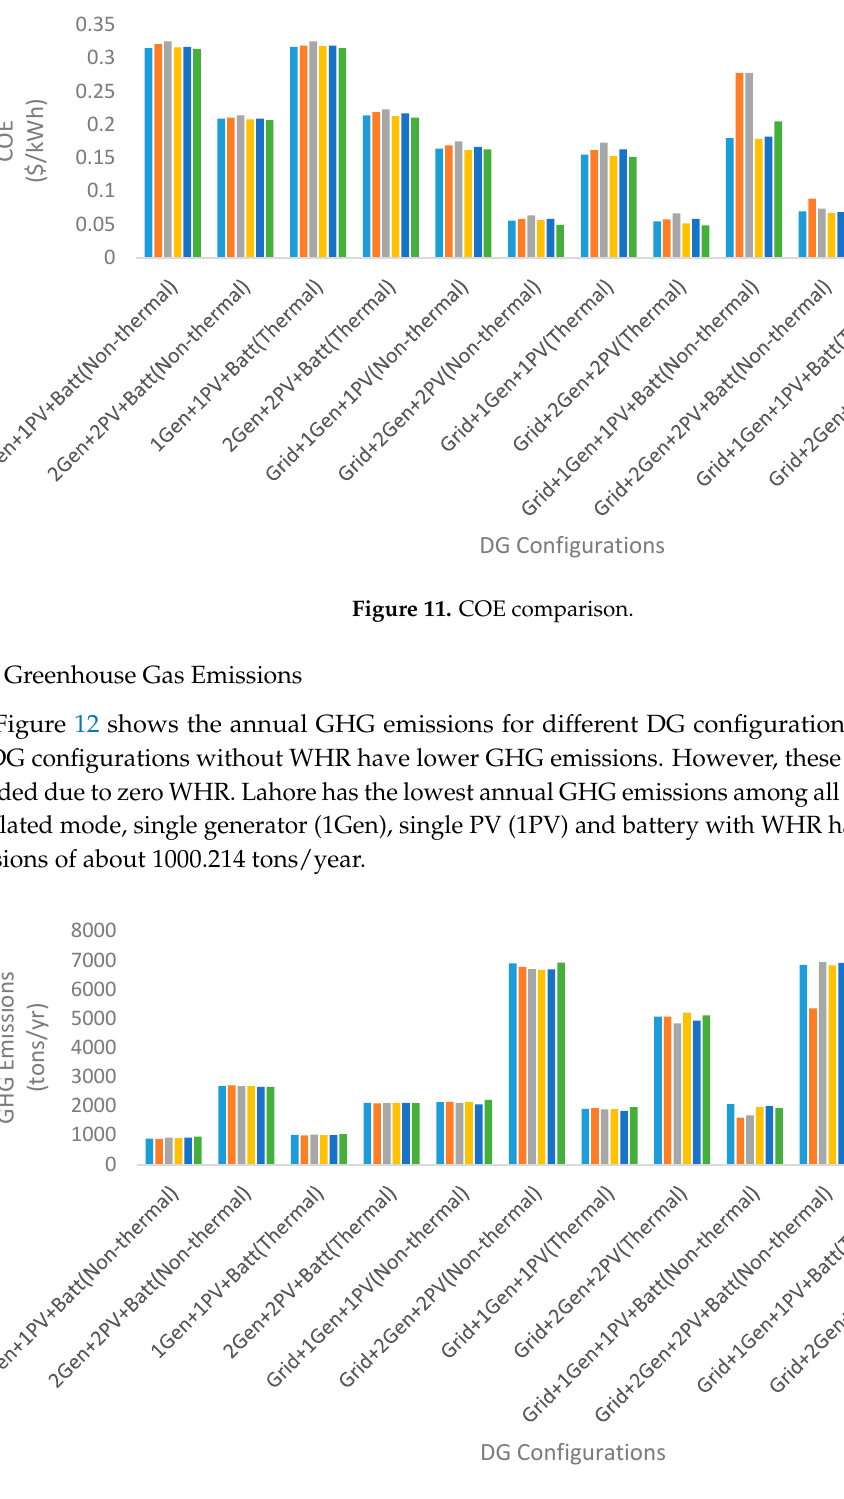
Gilgit Figure 12. GHG emissions